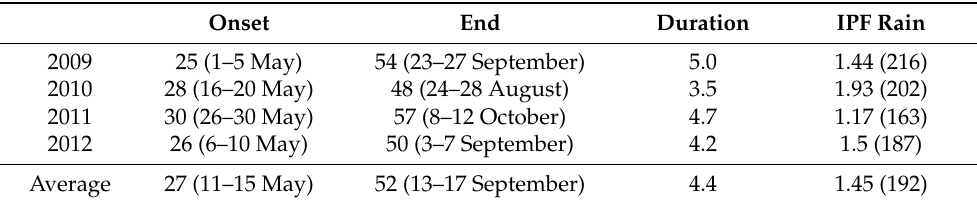
Table 1. IPF season onset (pentad and date), end (pentad and date), and duration (number of months) for the SE US domain, for each individual year (2009–2012) and for the four years average. Domain-averaged IPF rain rate (in mm day − 1 ) and IPF season accumulated IPF rain (mm) are shown in parentheses.